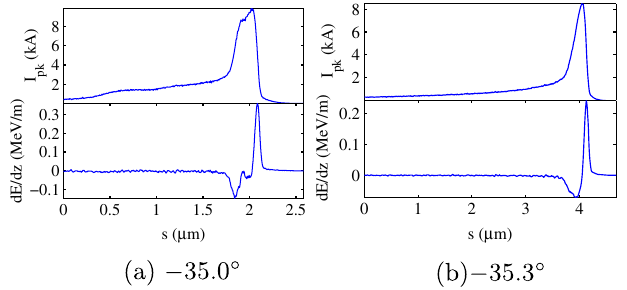
FIG. 7. Electron current profile (upper) and the energy modulation of electron bunch per unit length due to the LSC effect in the undulator (lower) in the cases with the L2 rf phase of − 35 . 0 ° (a) and − 35 . 3 ° (b). The electron bunch head is on the right-hand side.